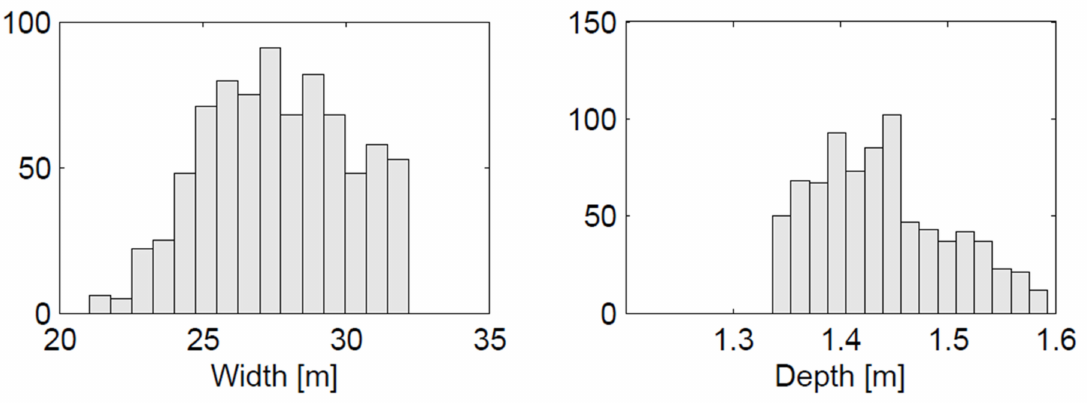
Figure 6. Predicted width and depth output from the UBCRM [63] for the Merced River below Crocker-Huffman Dam assuming 20% uncertainty in discharge and bank strength. Input scaling variables are Q bf = 59.5 m 3 /s, D 50 = 0.032 m, S = 0.002, and u = 1.01. The y-axis is the number of simulations performed in the Monte Carlo simulations that fall within specific values of width and